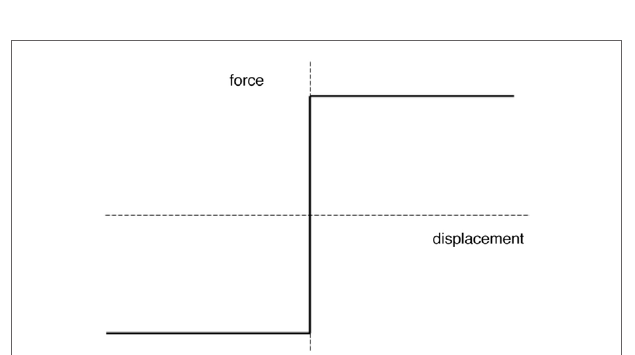
FigURe 3 | Coulomb friction .